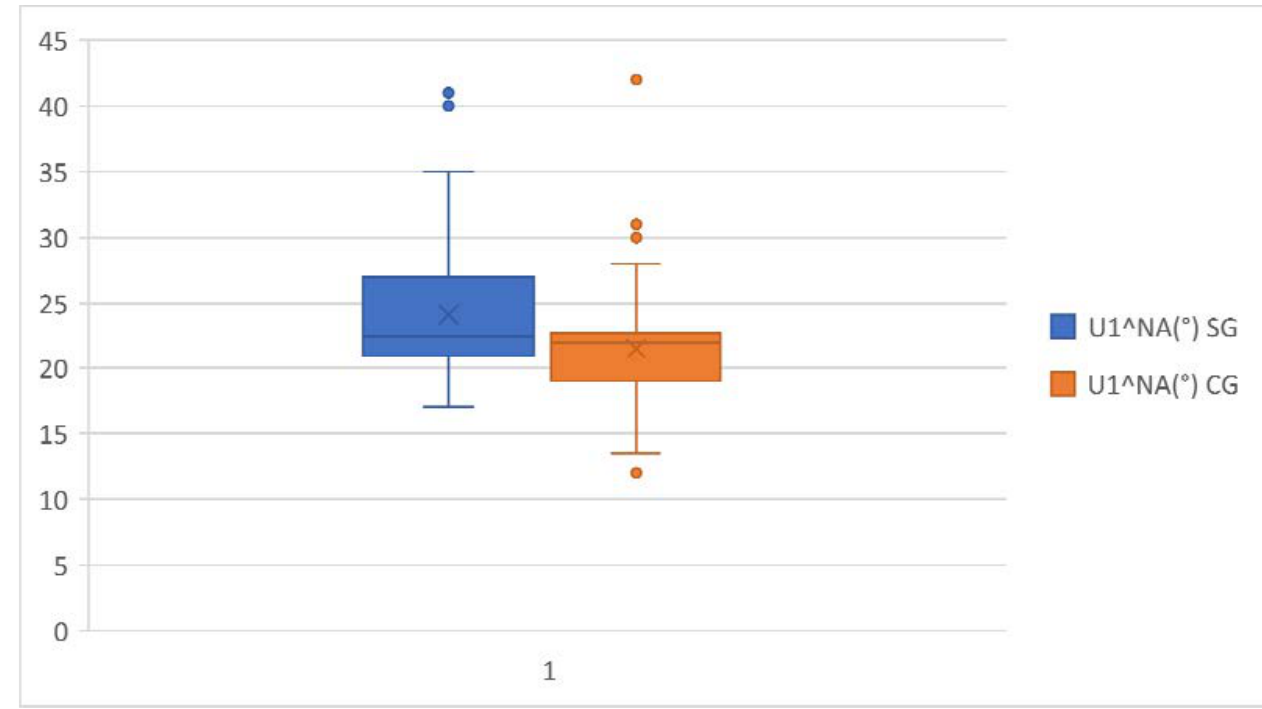
Figure 4. U1^NA comparison in the study group and the control group. Figure 4. U1ˆNA comparison in the study group and the control group.